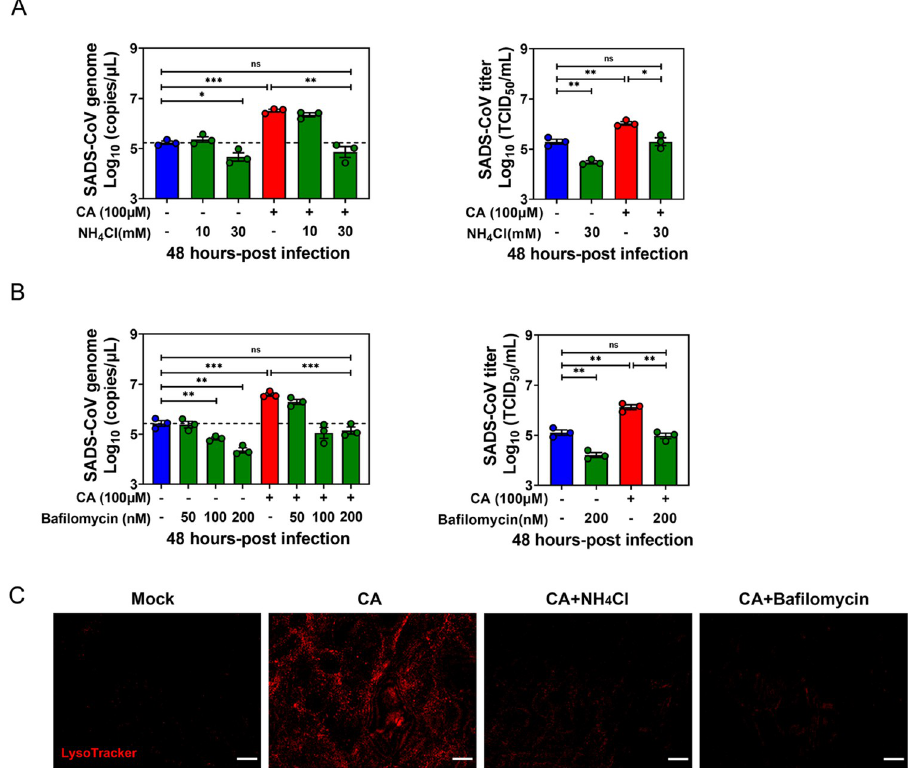
Fig 7. Bile acid (BA) enhances SADS-CoV replication through endosomal acidification. Porcine intestinal enteroid (PIE) monolayers were pretreated with (A) NH 4 Cl and (B) bafilomycin A1 at the indicated concentrations for 1 h before infection, and harvested at 48 hpi. NH 4 Cl and bafilomycin A1 were supplemented during and post-infection. (C) PIE monolayers were treated with either medium alone, 100 μ M CA, 100 μ M cholic acid (CA) plus 30 mM NH 4 Cl or 100 μ M CA plus 200 nM bafilomycin A1 for 1 h, washed with PBS three times and incubated with 200 nM LysoTracker for 30 min at 37˚C (scale bar, 10 μ m). Images were collected on an LSM880 confocal laser-scanning microscope (Zeiss). Data are from three independent experiments. P values were determined by unpaired two-tailed Student’s t test; � : p < .05; �� : p < .01; ��� : p < .001; ns, not